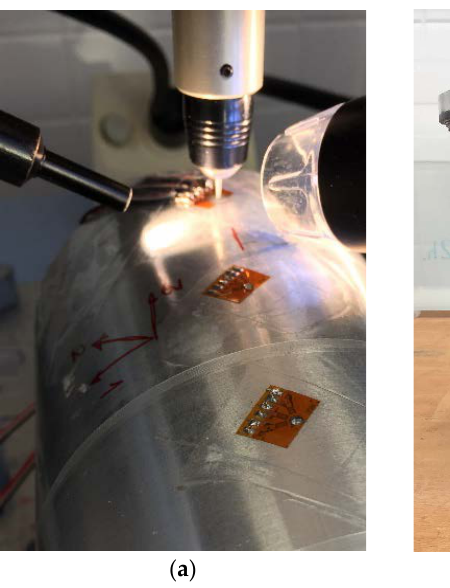
Figure 3. ( a ) Residual stress measurement of noncorroded specimen. ( b ) Specimen corroded after 72 h in solution of distilled and deionized water and NaCl (3.5%). ( c ) Set up of measures in corroded specimen.